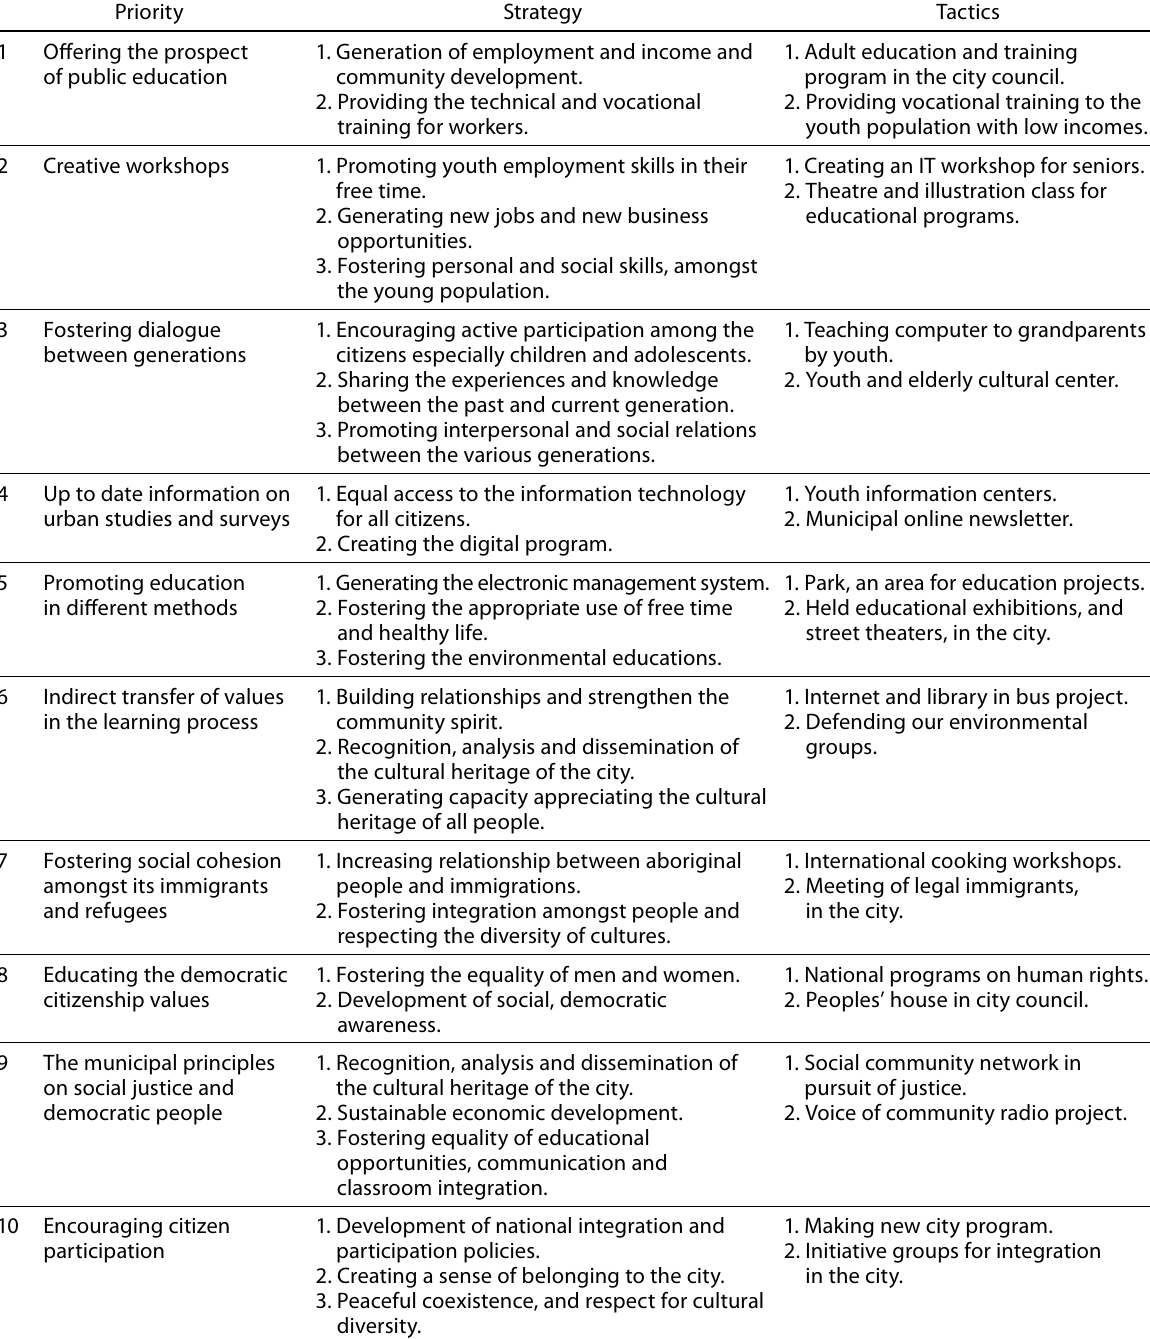
Table 5. The proposed programs to change Tehran into the educating city Priority Strategy